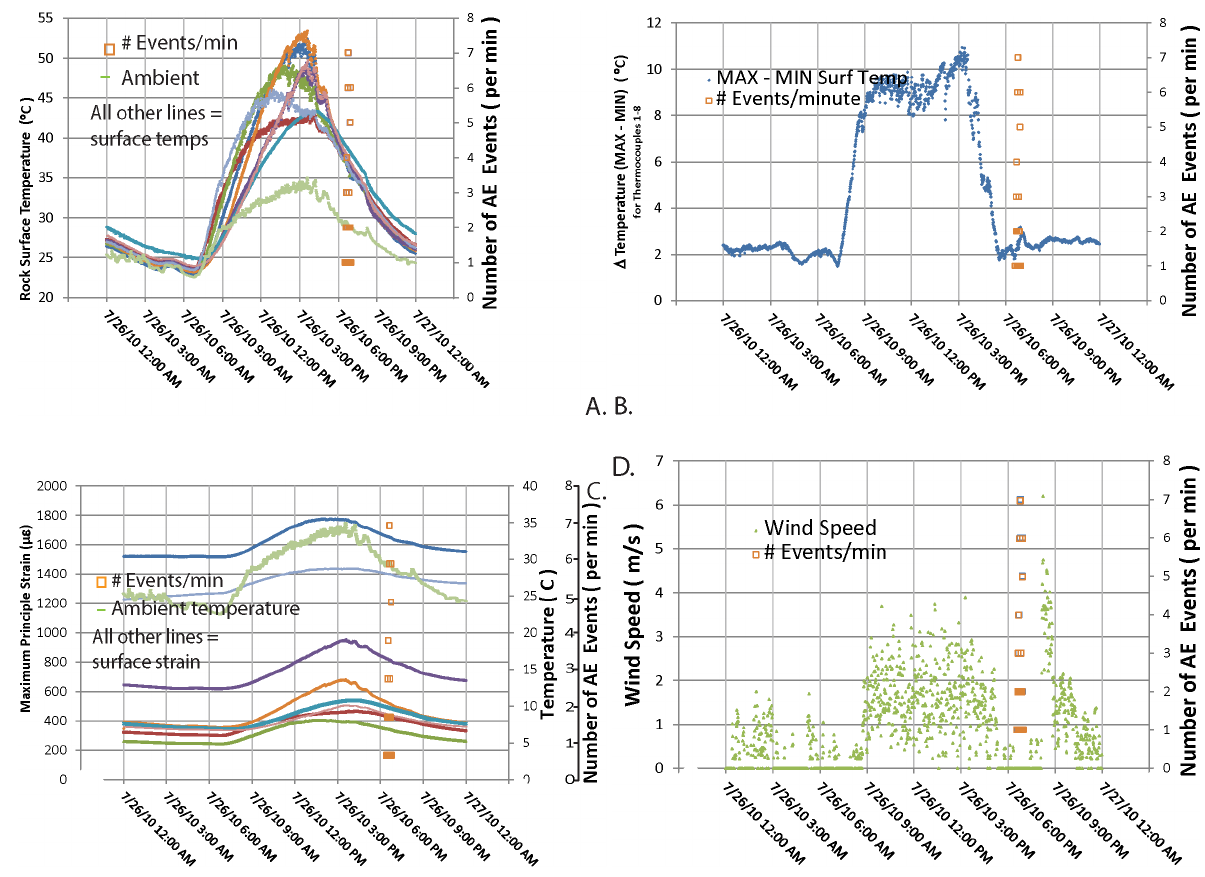
Fig. 5. Graphs of total numbers of events per minute (each orange box represents data for an individual minute) for a single day (26 July 2010) along with concurrent per minute. (A) Rock surface and ambient temperature, (B) temperature difference between the hottest and coldest thermocouple on the rock, (C) calculated maximum principal strain for all 8 strain gages and ambient temperature, and (D) wind speed measured adjacent to the